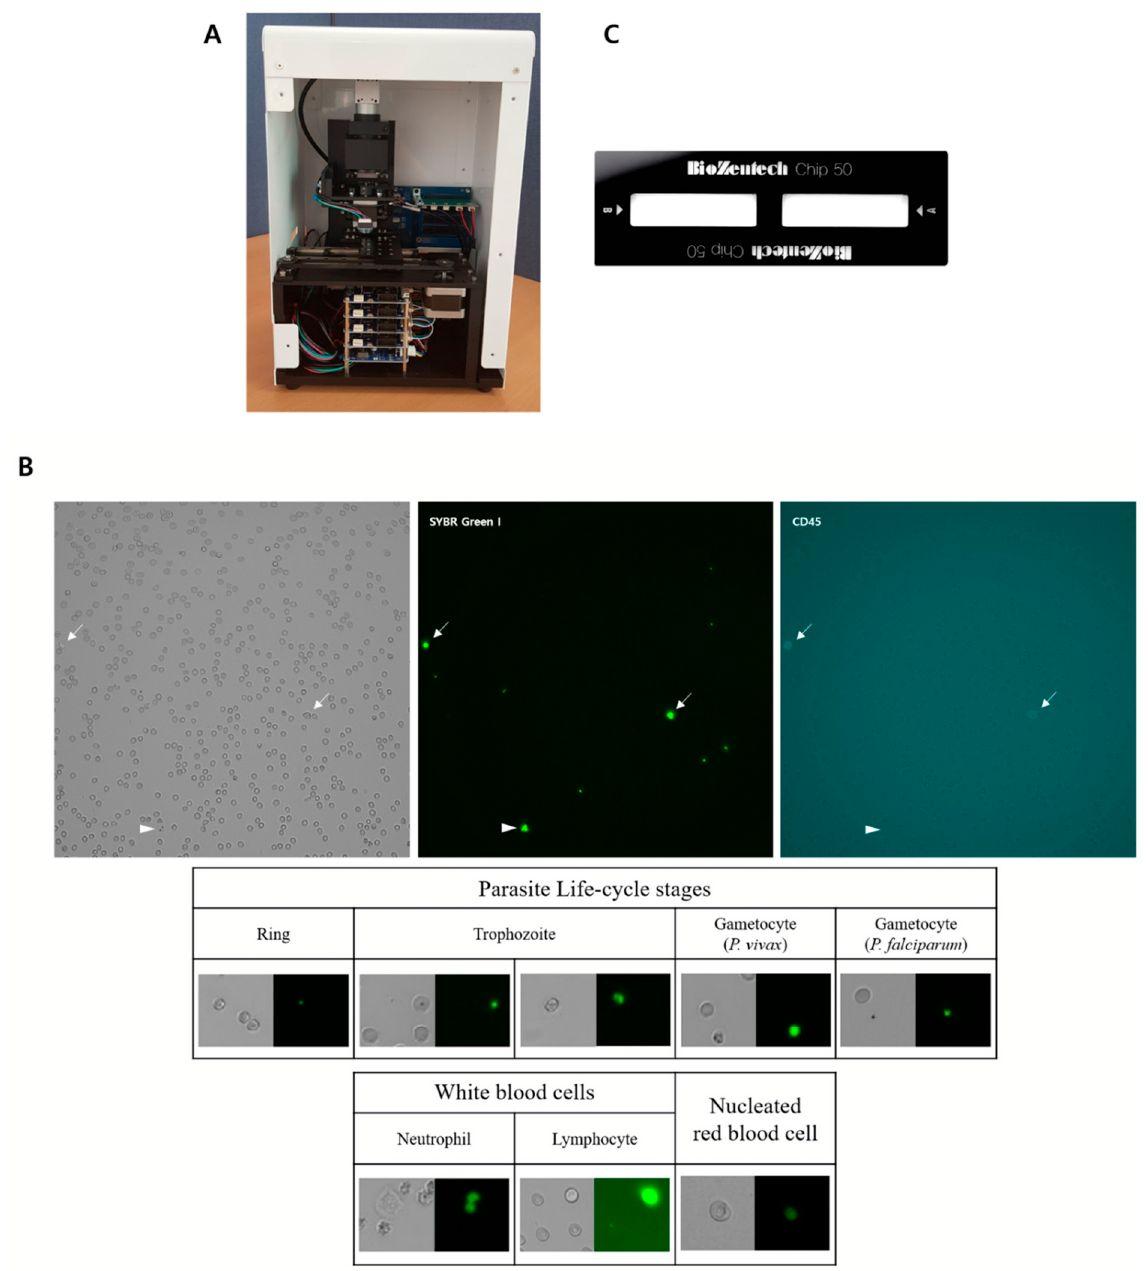
Figure 1. The automated microscopic malaria parasite detection system. ( A ) Automated microscopic malaria parasite detection system hardware. ( B ) Image of stained malarial parasite-infected blood cells showing malarial parasites, white blood cells (WBCs) and nucleated red blood cells obtained using the automated microscopic malaria parasite detection system at 40 × magnification (1200 × 1200 pixel 2 ). The image is obtained at green LED (upper left), blue LED (upper middle) and red LED (upper right) are shown. The arrows indicate WBCs and the arrow heads indicate gametocyte. The example images of P. vivax at different stages, P. falciparum gametocyte and WBCs are also shown. ( C ) The plastic chip for the automated microscopic malaria parasite detection system.